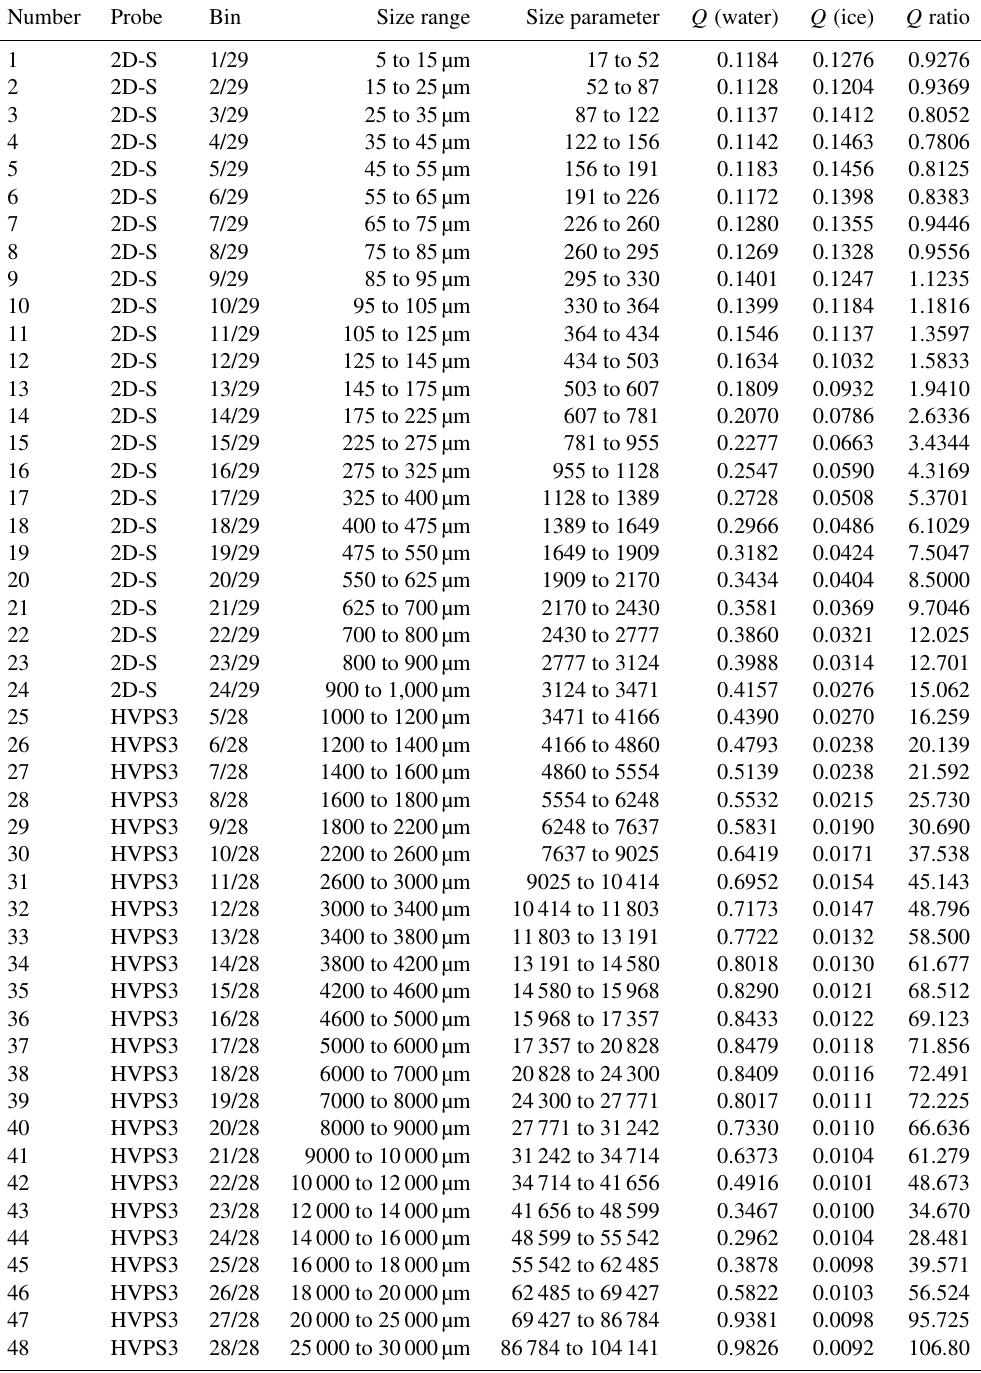
Table 1. Table listing parameters for the particle size distribution created by combining the two-dimensional stereo (2D-S) and High-Volume Precipitation Spectrometer Version 3 (HVPS3) probe measurements. The ”Number” column lists the combined spectrum channel number, the ”Probe” column indicates which probe made the measurements, and the ”Bin” column gives the original probe’s channel number and total channels. The ”Size range” column gives the lower and upper sizes of particles within the channel. The ”Size parameter” column gives the scattering size parameter (Eq. 3) range for the lower and upper particle sizes at a wavelength of 905nm. The ”Water” column lists backscatter efficiency for water particles, and the ”Ice” column lists backscatter efficiency for ice particles. The ” Q ratio” column gives the ratio of the backscatter efficiency of water to the backscatter efficiency of ice. The MiePlot software package is used to calculate average efficiencies using particle diameters that span the combined spectrum